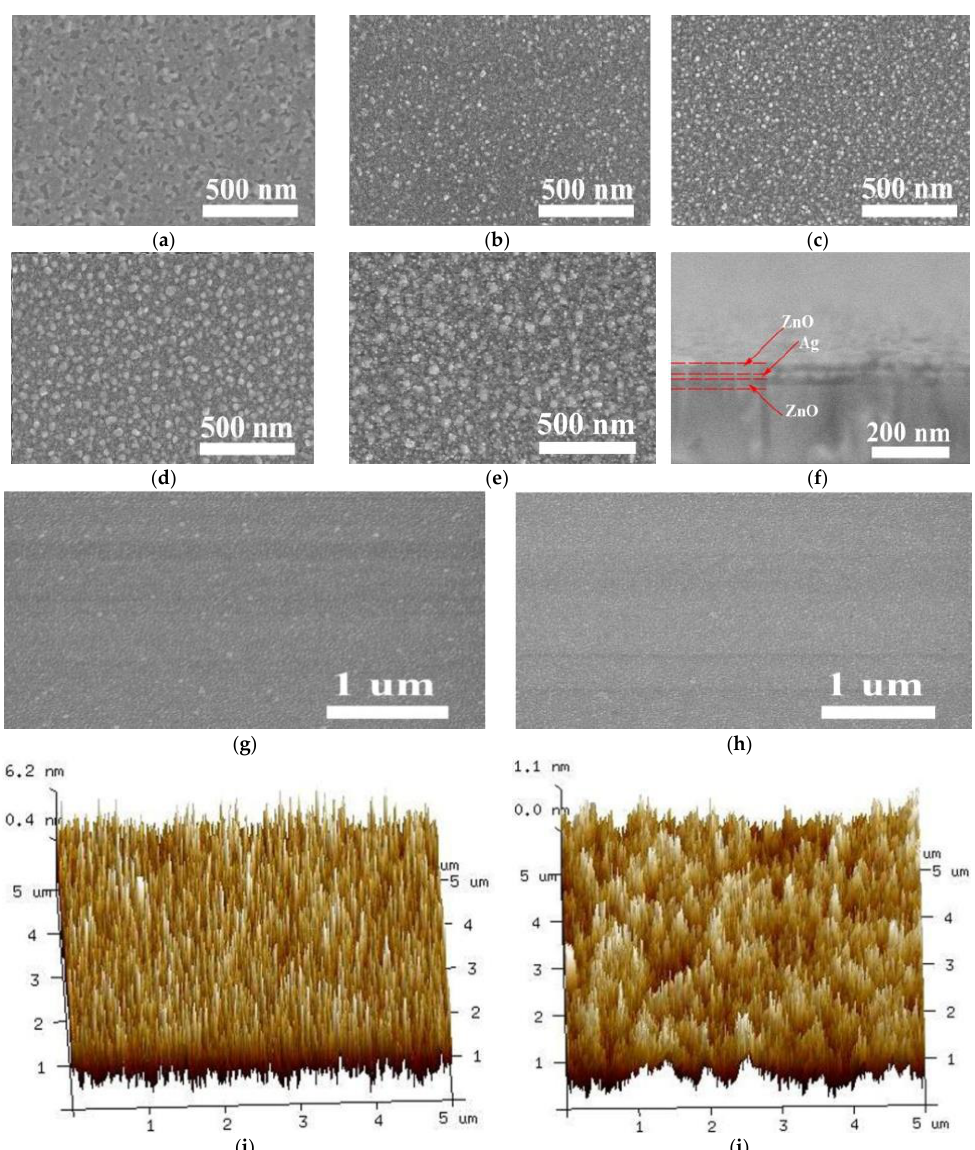
Figure 3. Scanning electron microscope (SEM) of the surface morphology of Ag with different f(O 2 ): ( a ) 0; ( b ) 1.0%; ( c ) 2.0%; ( d ) 3.0% and ( e ) 4.0%. ( f ) A cross-section image of ZnO/Ag/ZnO (f(O 2 ) = 3%). SEM of the surface morphology of ZnO/Ag ZnO with different f(O 2 ): ( g ) 0 and ( h ) 3.0%. Atomic force microscope (AFM) of the surface morphology of ZnO/Ag/ZnO with different f(O 2 ): ( i ) 0 and ( j ) 3.0%.